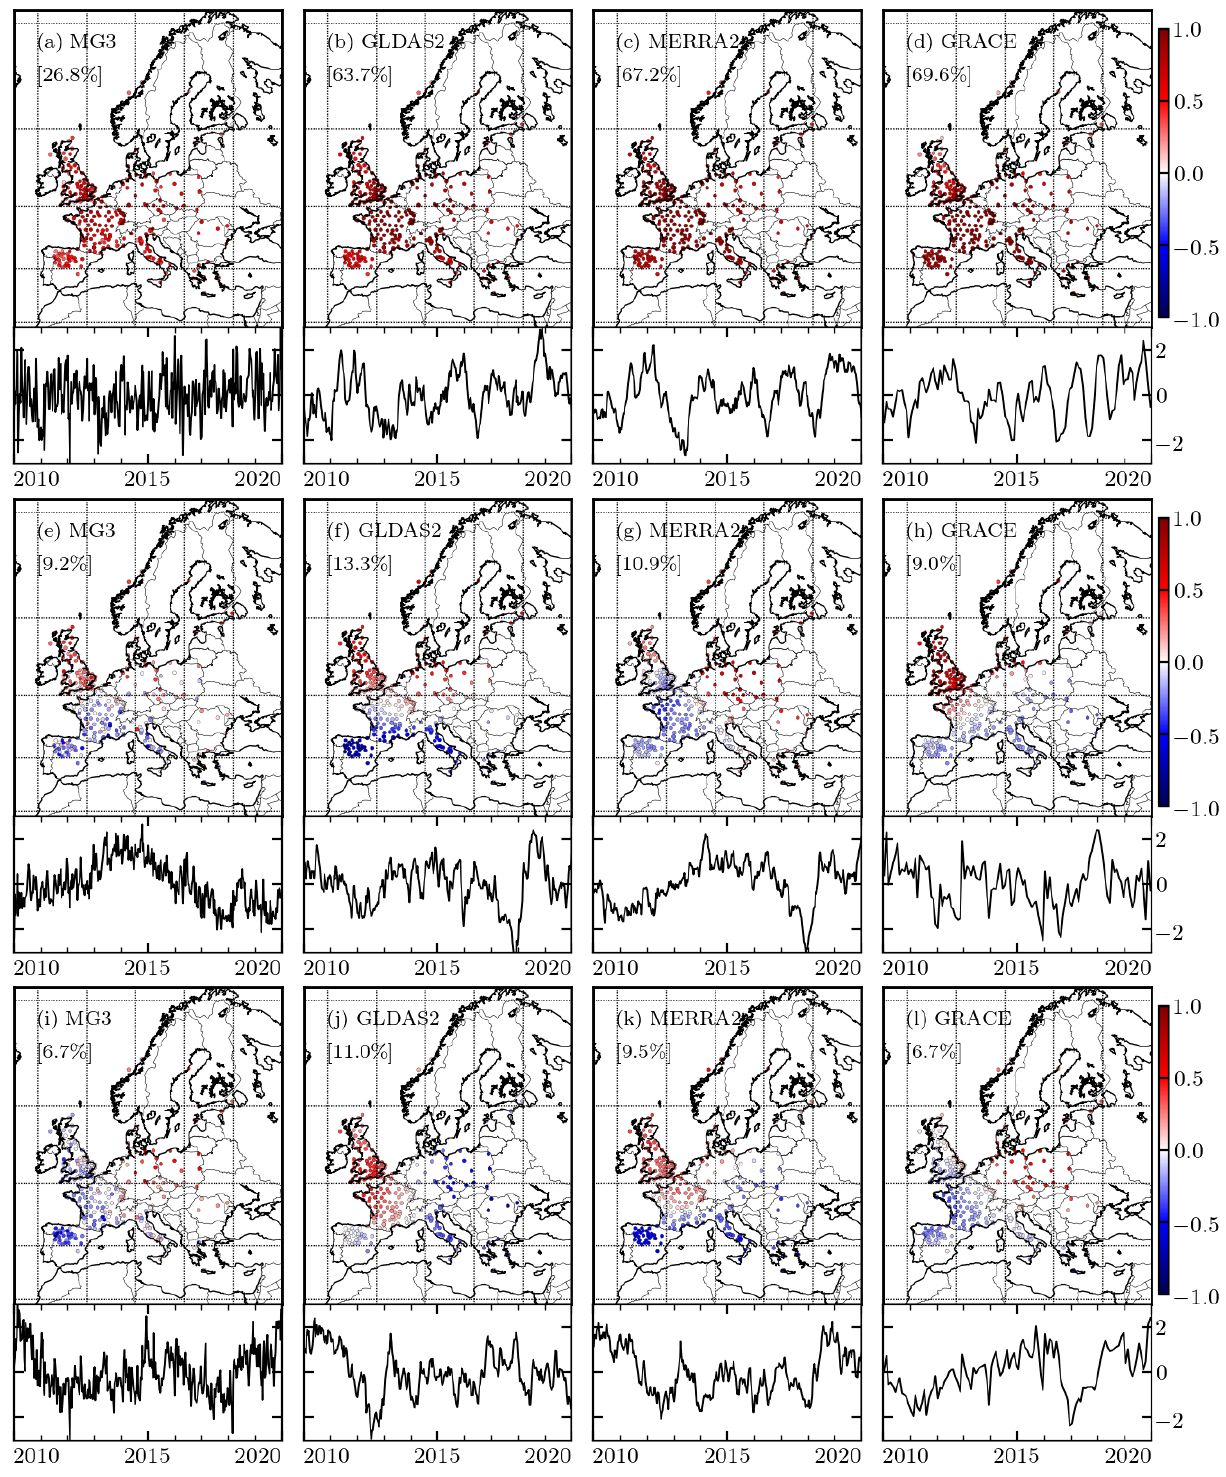
Figure 10. PCA (EOFs and associated PCs) of GNSS and the three loading models’ (including GRACE) residual time series between 2010 and 2020, where the trend and the seasonal signal have been removed: ( a – d ) first component, ( e – h ) second component, and ( i – l ) third component. The percentage of the total variance corresponding to each mode is given in each plot. The PCs are scaled to unit variance and plotted for the period 2010 to 2020, while the corresponding EOFs are given in terms of the correlation between the initial time series and the